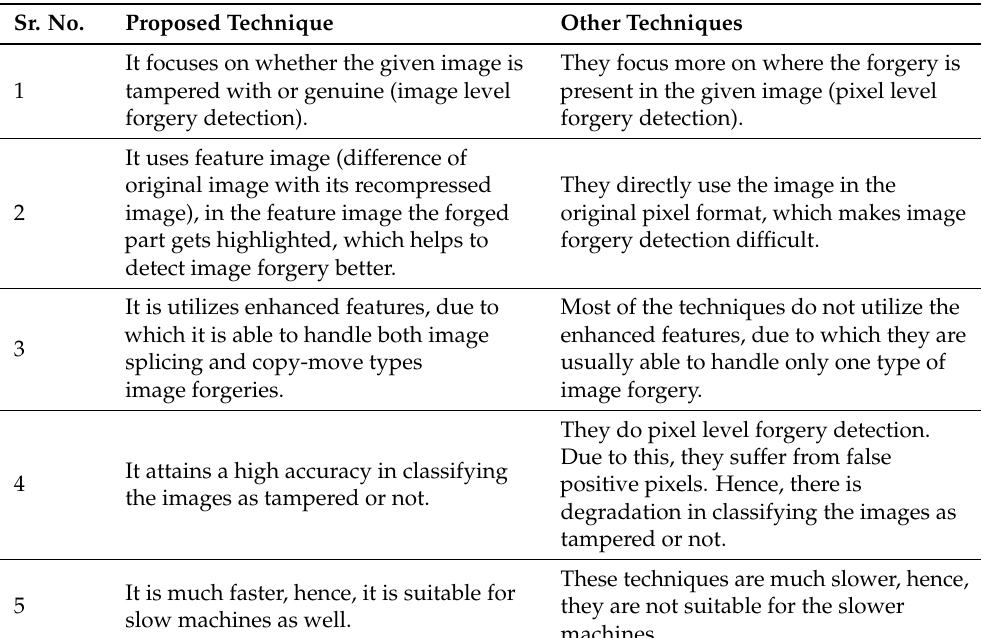
Table 4. Comparison of the proposed technique with the other techniques [2,3,27]. Sr.